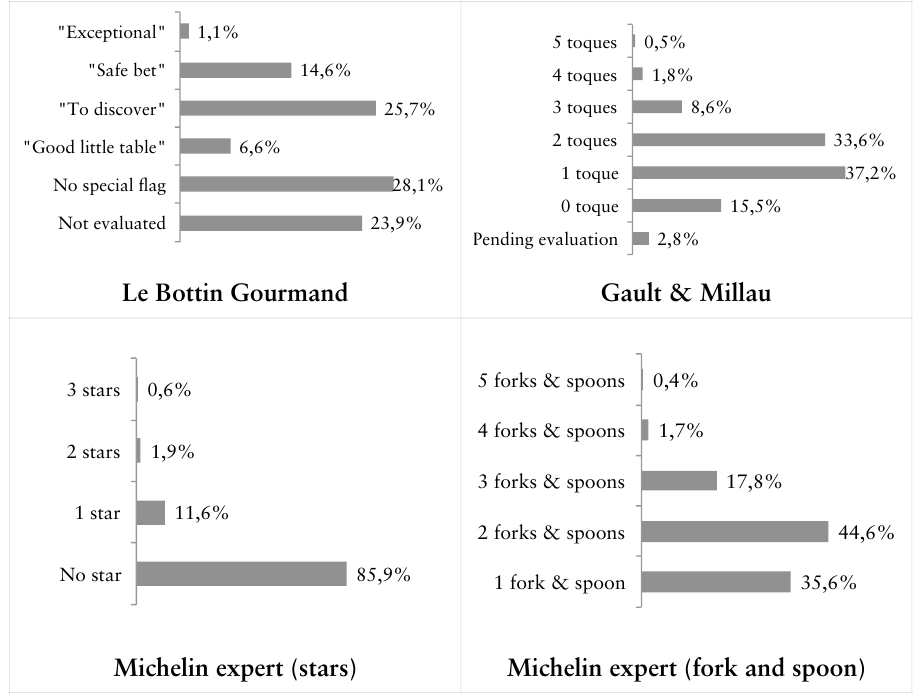
Figure 2. Distribution of restaurant ratings by traditional gourmet guides.